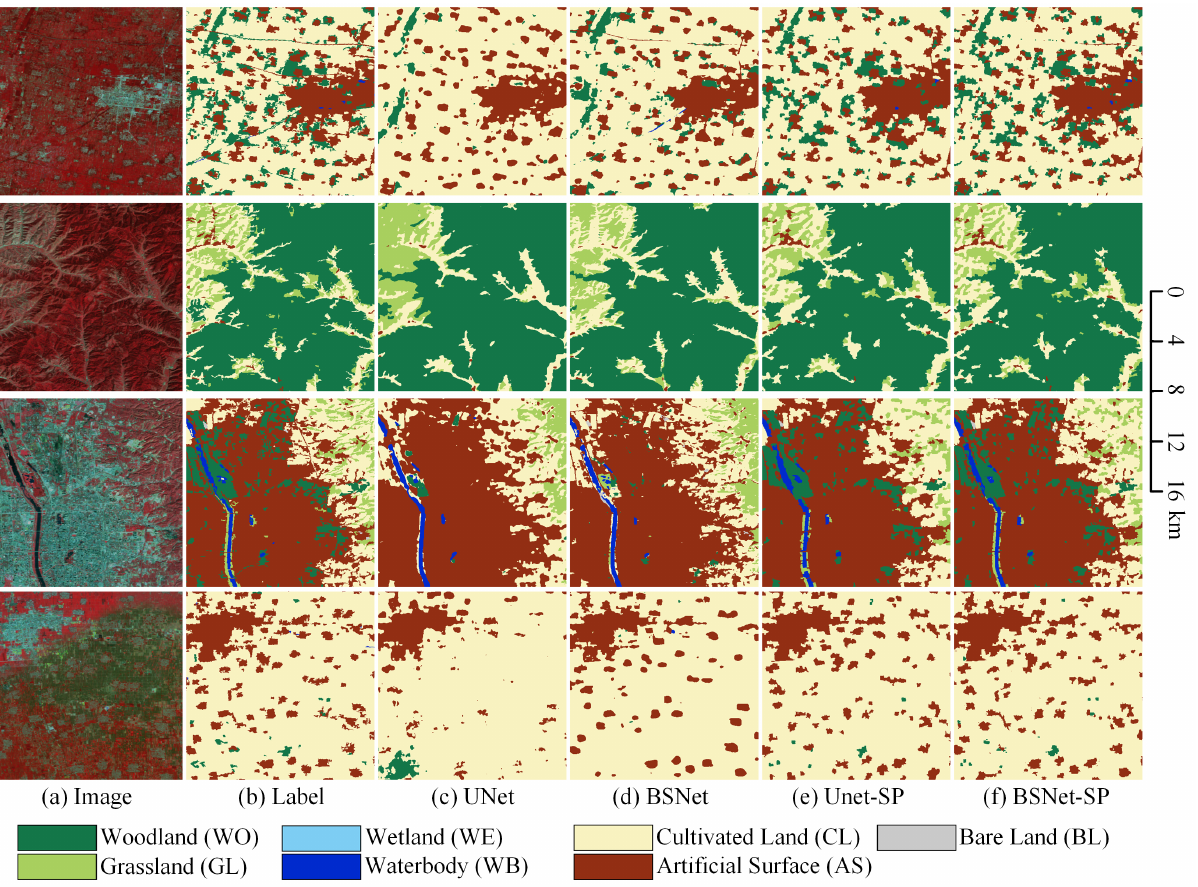
Figure 13. Ablation study with the block shuffle structure and superpixel branch on Landsat extend dataset. ( a ) Landsat image. ( b ) Ground truth. Inference result of ( c ) the UNet, ( d ) the UNet with the block shuffle structure (BSNet), ( e ) the UNet with the superpixel branch (UNet-SP), and ( f ) the BSNet with the superpixel branch